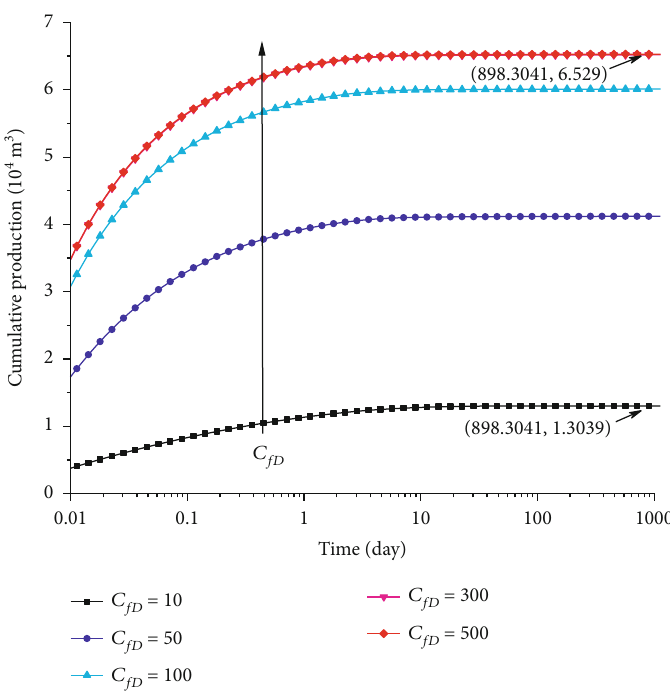
Figure 10: The e ff ect of fracture conductivity on cumulative production (constant pressure).